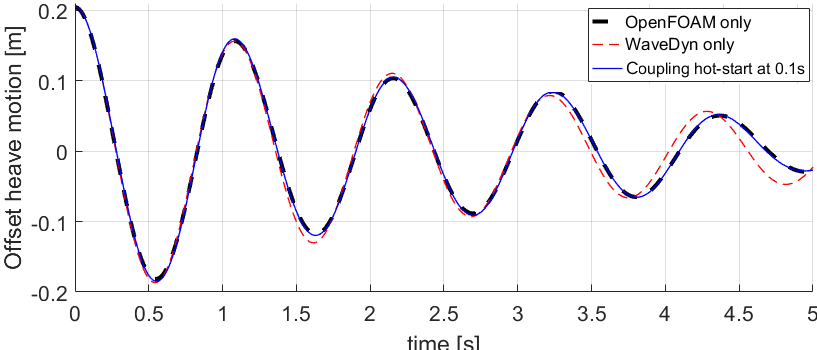
Figure 14. Heave decay responses demonstrating coupling at hot-start time t hot = 0.1s ( t minus = 0).